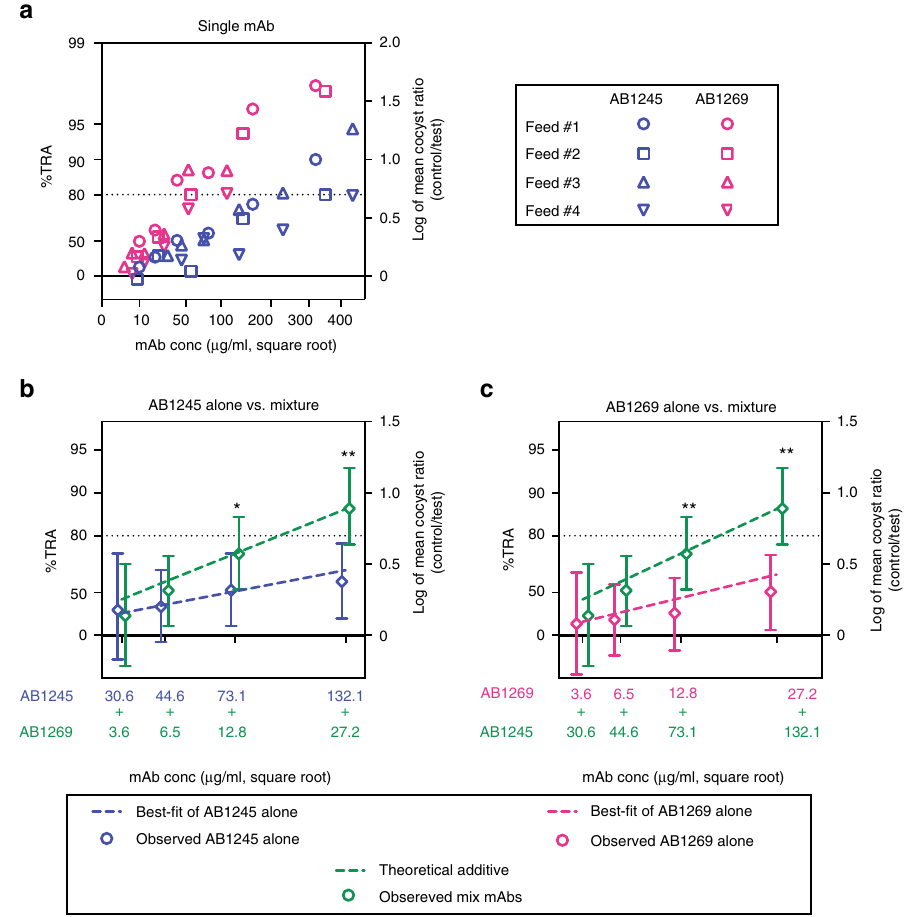
Fig. 7 MAbs 1245 and 1269 display an additive effect in SMFA. a 1245 and 1269 antibodies were tested at multiple concentrations in four independent assays. Each antibody concentration is shown on a square root scale ( x -axis). The associated % inhibition (%TRA) value is shown on the left side of the y - axis. The ratio of mean oocyst (mean oocyst density in control divided by mean in test) is plotted on a log scale (log mean ration, right side of y -axis). b , c 1245 and 1269 antibodies were tested at indicated concentrations either alone or a mixture of the two mAbs. The best-estimated %TRA and the 95% CIs of mean oocyst density calculated from two independent assays are shown (observed). In addition, the best- fi t line of each mAb and the theoretical additive values (assuming the two antibodies work additively) are shown as dotted lines. b is depicted based on the 1245 antibody concentration ( x -axis) and c by 1269 antibody concentration, and the same SMFA data from mixture groups are plotted in both fi gures. An asterisk indicates that the mixture group showed signi fi cantly higher %TRA than the corresponding single mAb group (* < 0.05; ** < 0.01). The p values were calculated using the zero-in fl ated negative binomial model described previously was plotted against the square root of antibody concentration ( x - axis). MAb 1269, with an IC 80 of 63 μ g/ml (95% CI, 53 – 75), was